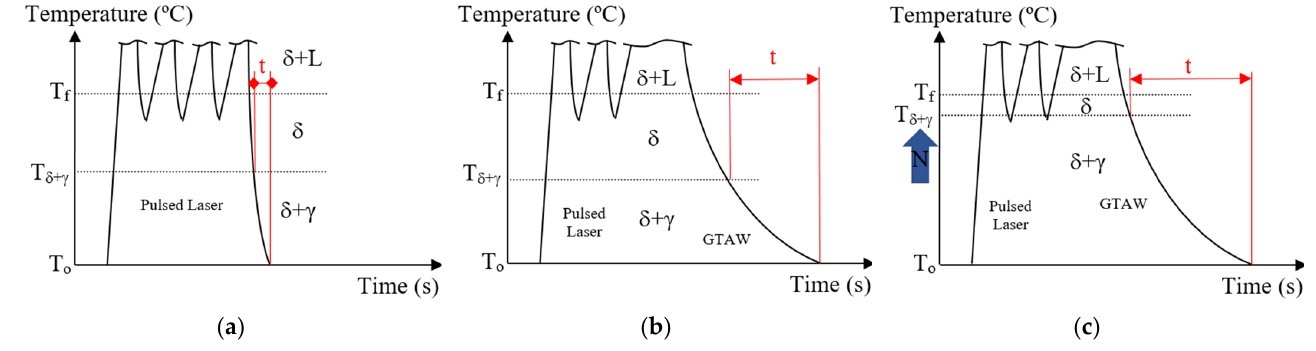
Figure 2. Time (t) the fusion zone remains in biphasic zone ( δ + γ ) while cooling in ( a ) pulsed laser Nd-YAG welding, ( b ) hybrid GTAW pulsed laser welding and ( c ) hybrid GTAW pulsed laser welding with nitrogen addition.